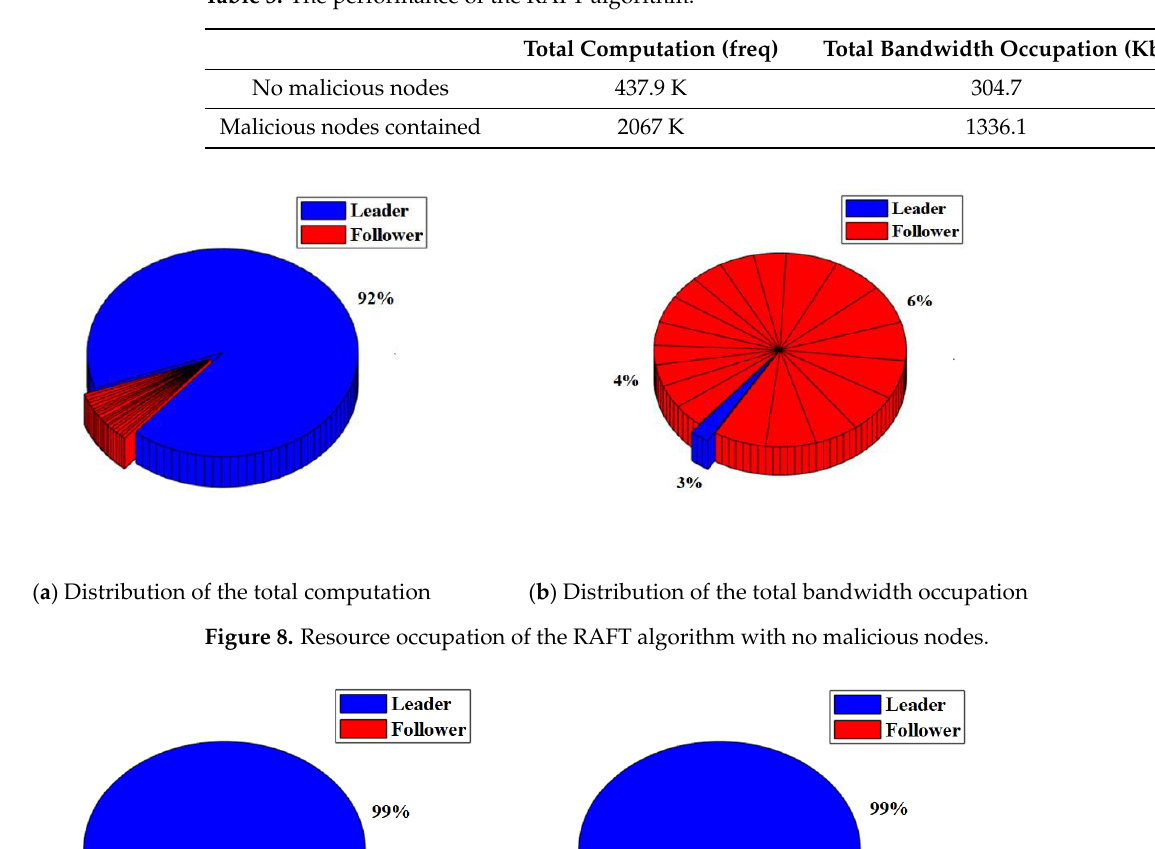
Table 3. The performance of the RAFT algorithm.